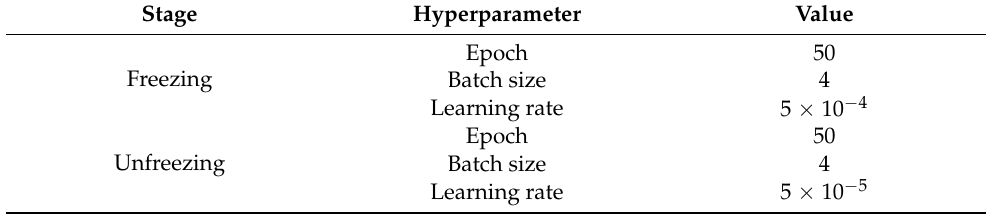
Table 2. DeepLabV3+ network training phase hyperparameter setting. Figure 8. Image segmentation and labelling.